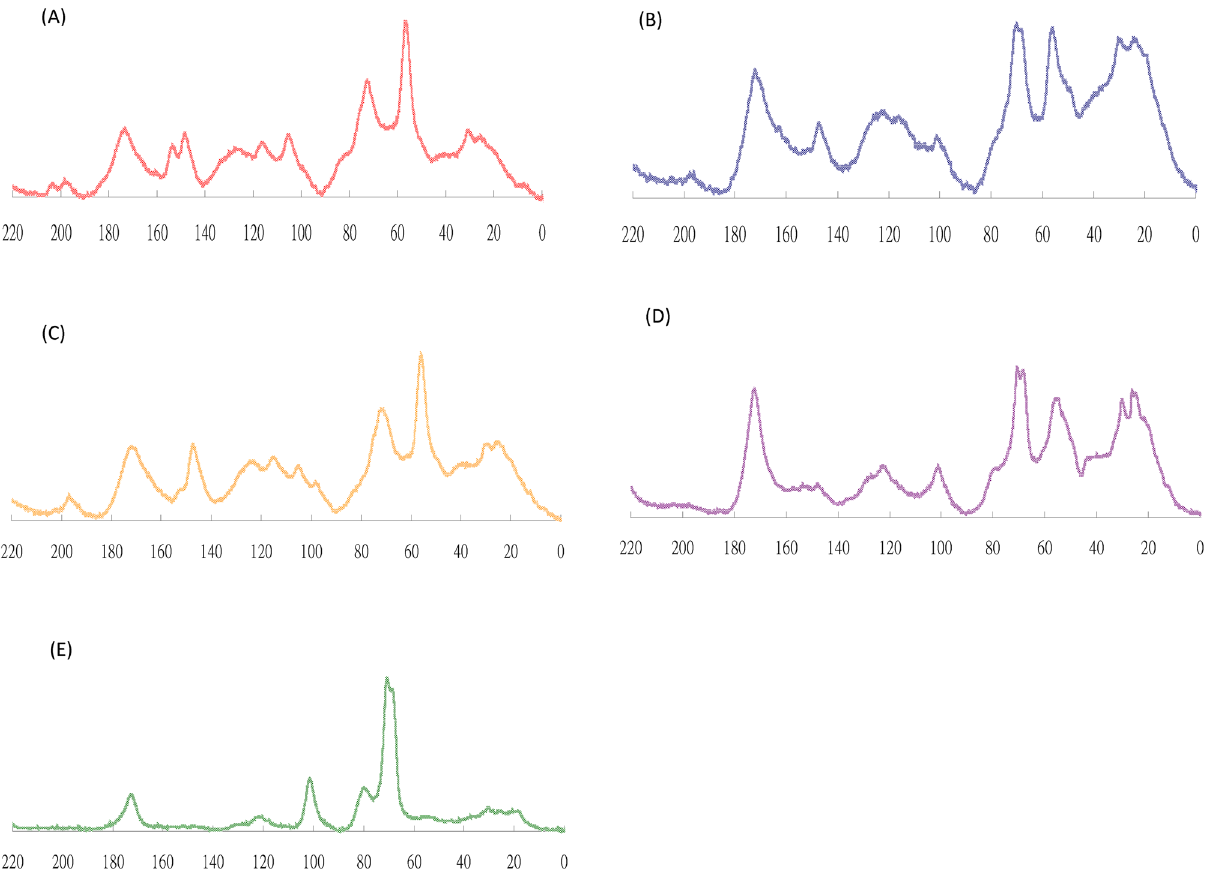
Figure 1. 13 C NMR graphs of five types of compost. ( A : chicken manure, B : cattle manure, C : pig manure, D : soybean manure, E : lemon peel